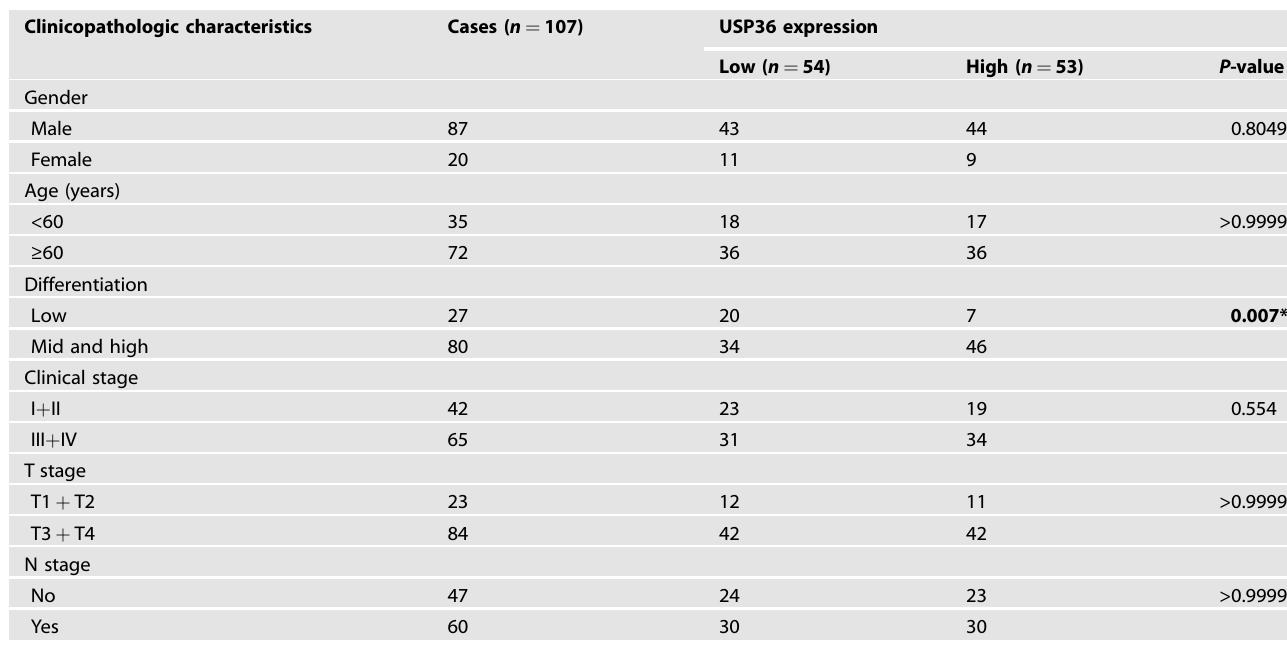
Table 1. Clinicopathological correlation of USP36 expression in